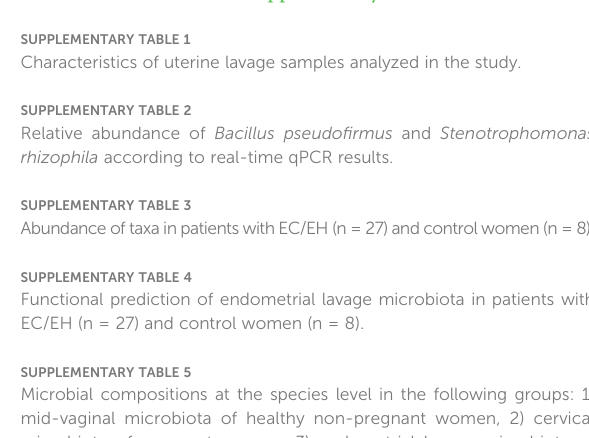
Microbial compositions at the species level in the following groups: 1) mid-vaginal microbiota of healthy non-pregnant women, 2) cervical microbiota of pregnant women, 3) endometrial lavage microbiota of women with benign endometrial lesions, and 4) endometrial lavage microbiota of women with EC/EH.